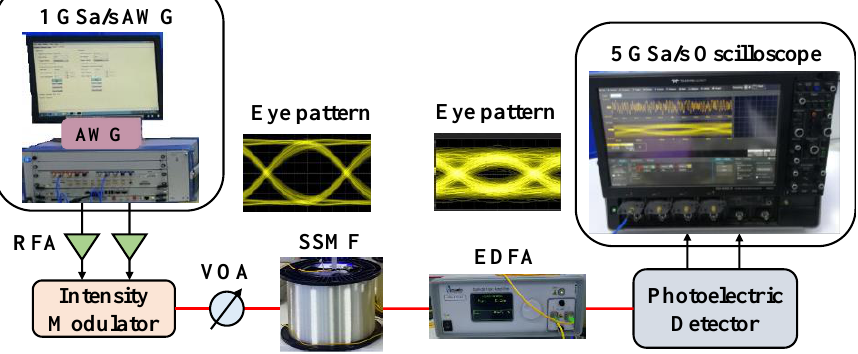
Figure 5. Experimental setup for key distribution over 200 km SSMF.